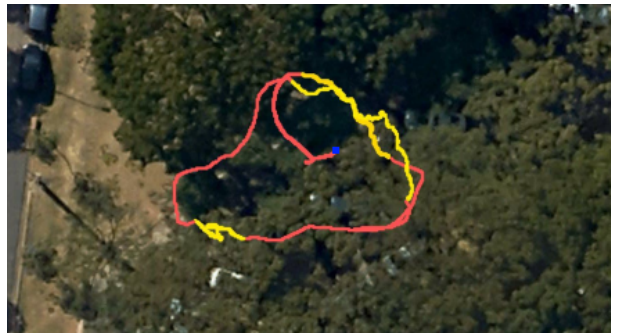
Figure 9. Satellite view of the forest where our experiments were executed. Image provided by Google Maps. The path estimated by RAUKF is shown in red whenever AHRS, LO, and GNSS were available and in yellow if only AHRS and LO were available. The vehicle’s starting point is represented by the blue